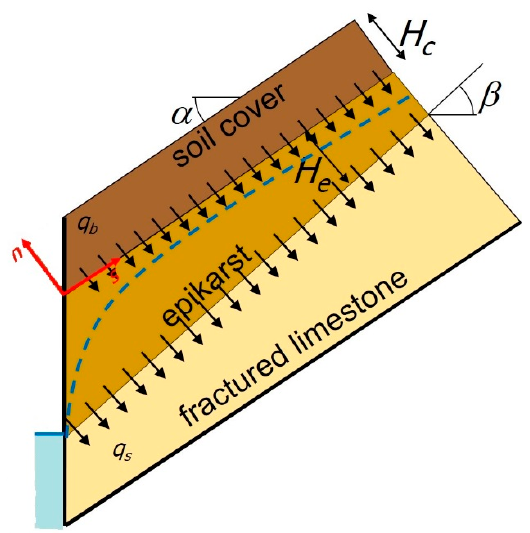
Figure 3 . Sketch of the flow domains of the coupled mathematical model of unsaturated soil cover and epikarst aquifer. The dashed blue line qualitatively represents the water table of the perched epikarst aquifer.